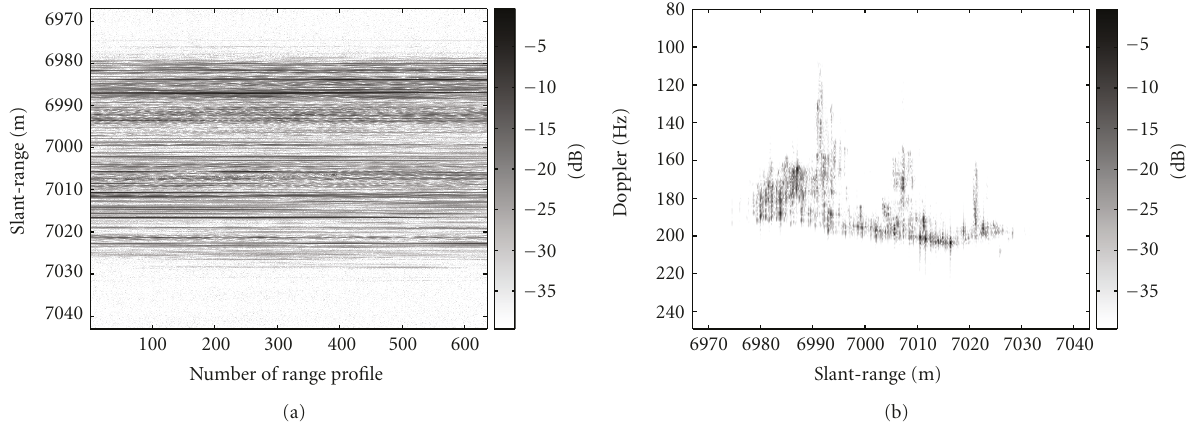
Figure 15: (a) Range profiles and (b) ISAR image for the real data of the vessel after applying the proposed method.